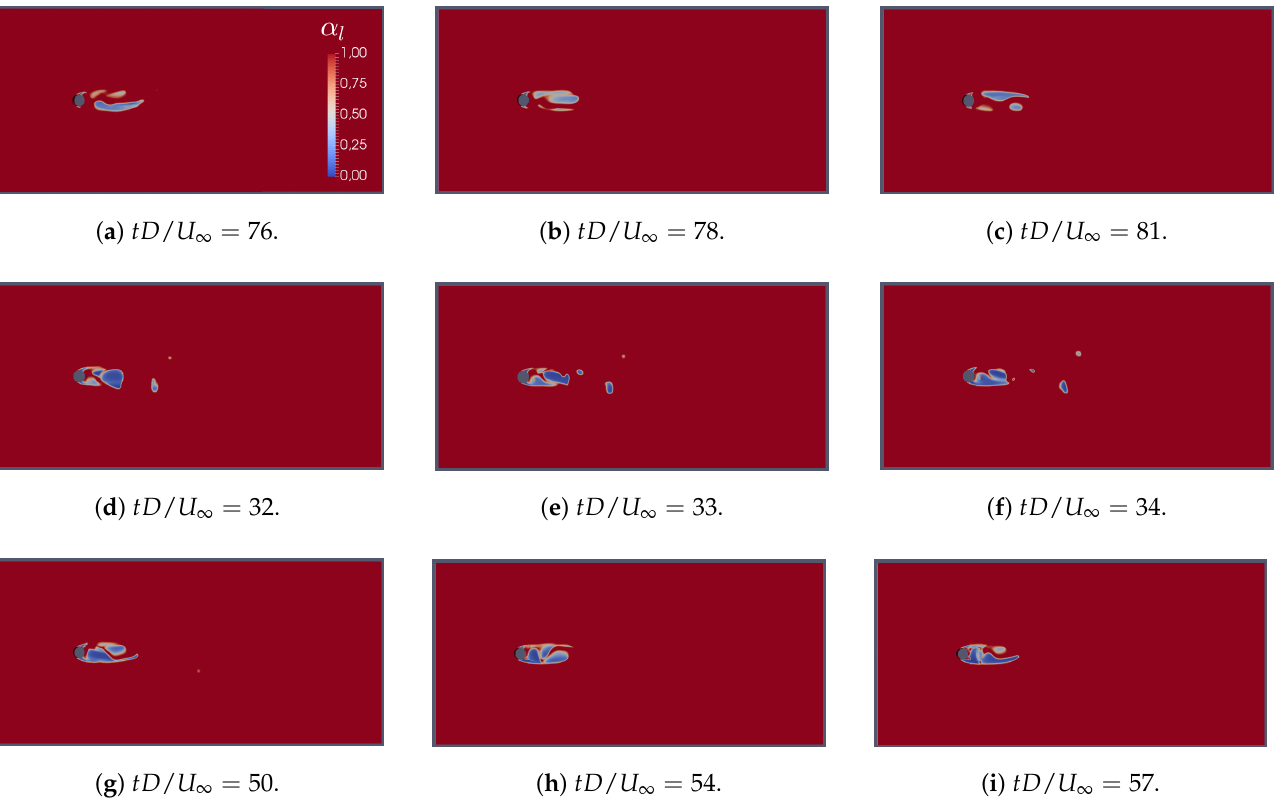
Figure 8. Contour plot of instantaneous liquid fraction, results obtained with SchnerrSauer model and considering standard